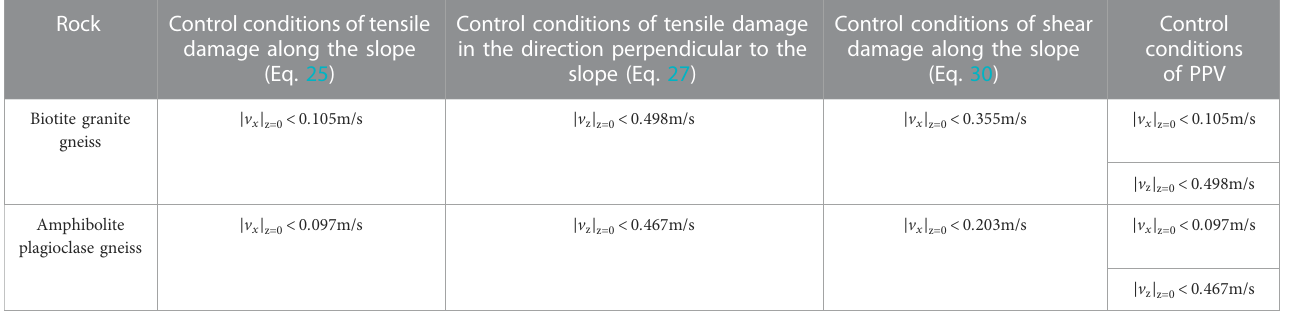
different rock mass parameters. The curves of different variables,